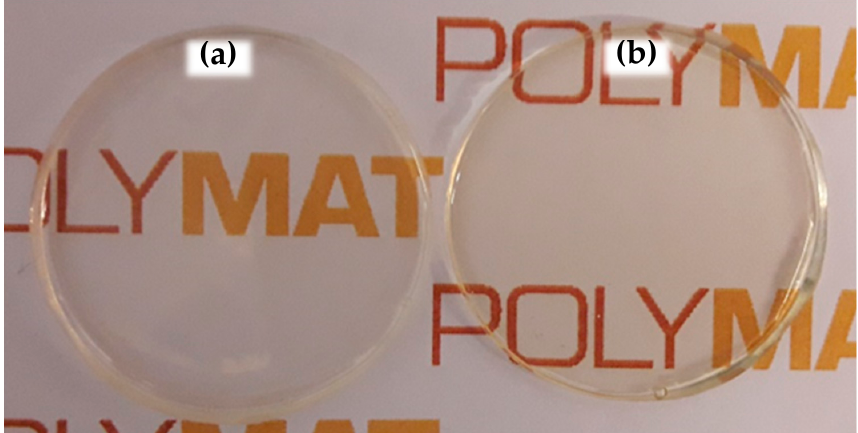
Figure 3. Free films formed at 24 ± 2 °C and 50 ± 5% relative humidity from ( a ) Bioacrylic latex and ( b ) hybrid CeO 2 -Bioacrylic latex.